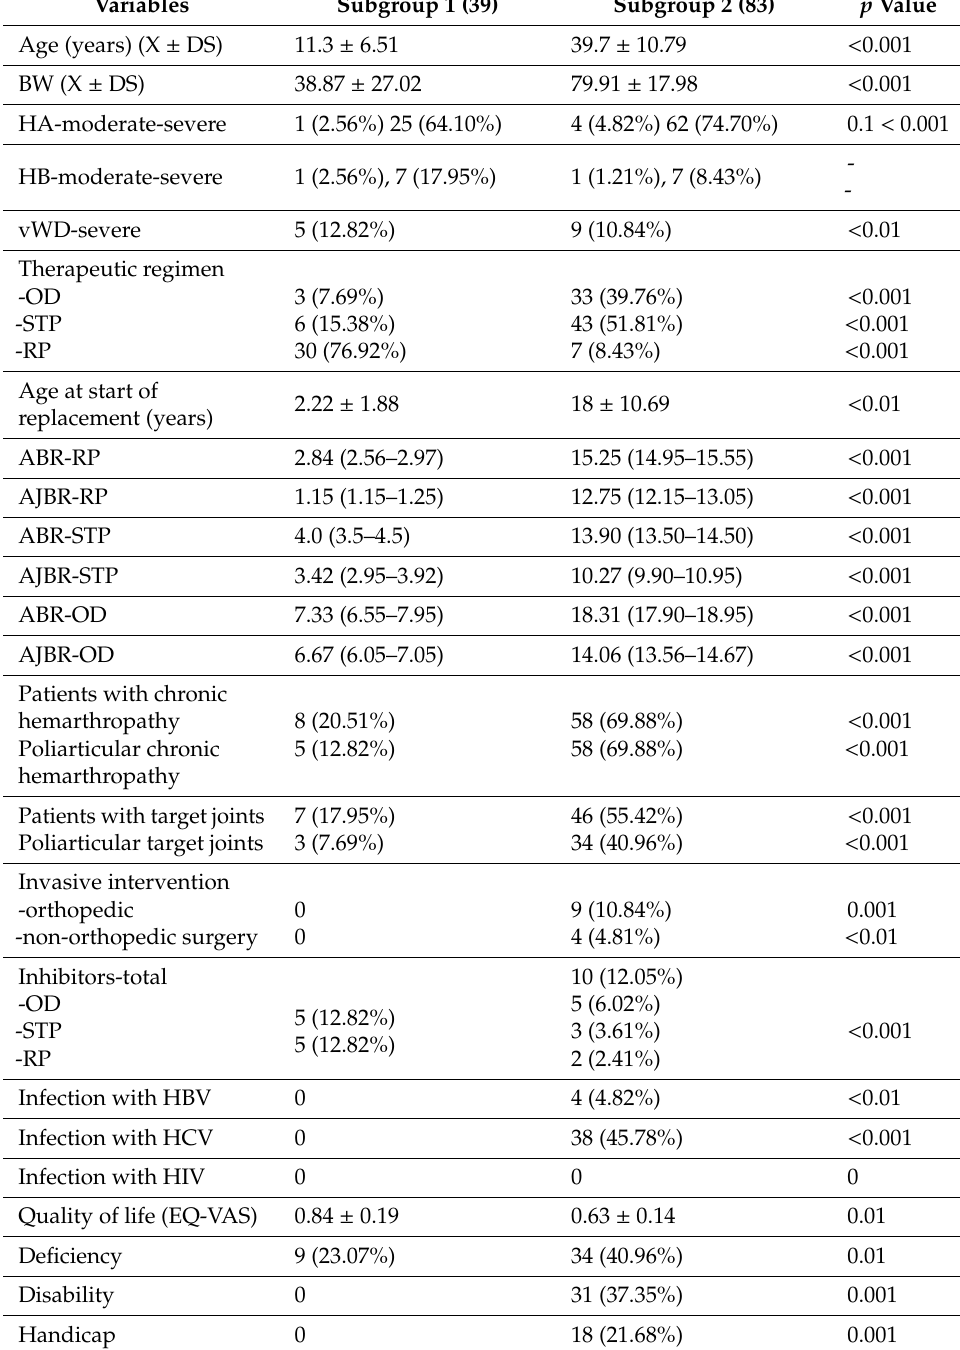
Table 1. Characteristics of the patients in subgroup (1) and